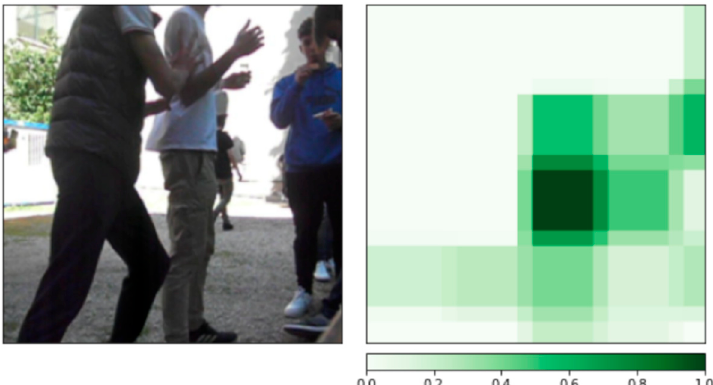
Figure 14. Original DSB image analysis using occlusion technique in which the model tries to classify by coloring in green the critical areas for the decision.